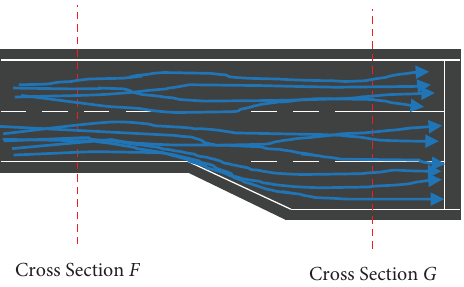
Figure 5: Te relationship between lane-changing behavior and the lane